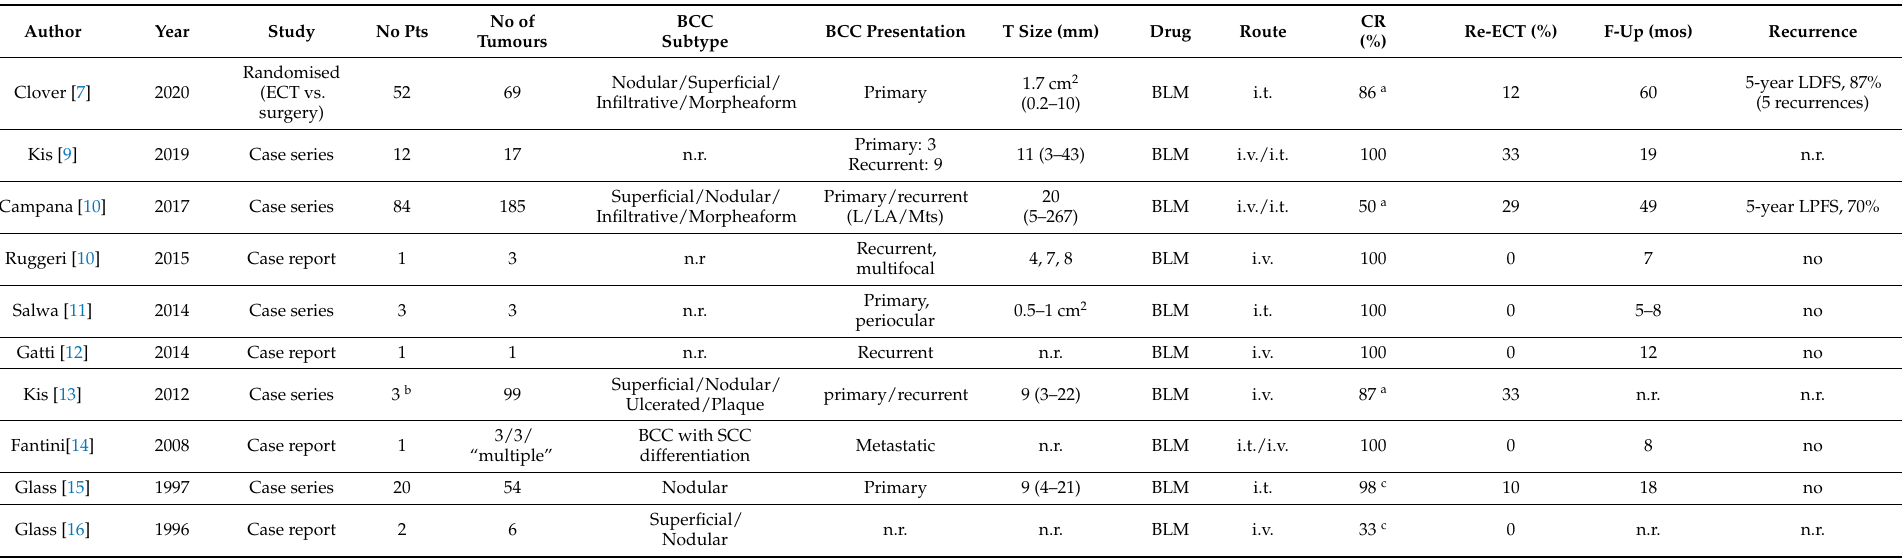
Table 5. Published series on ECT in BCC (additional studies in unselected populations are available in Table